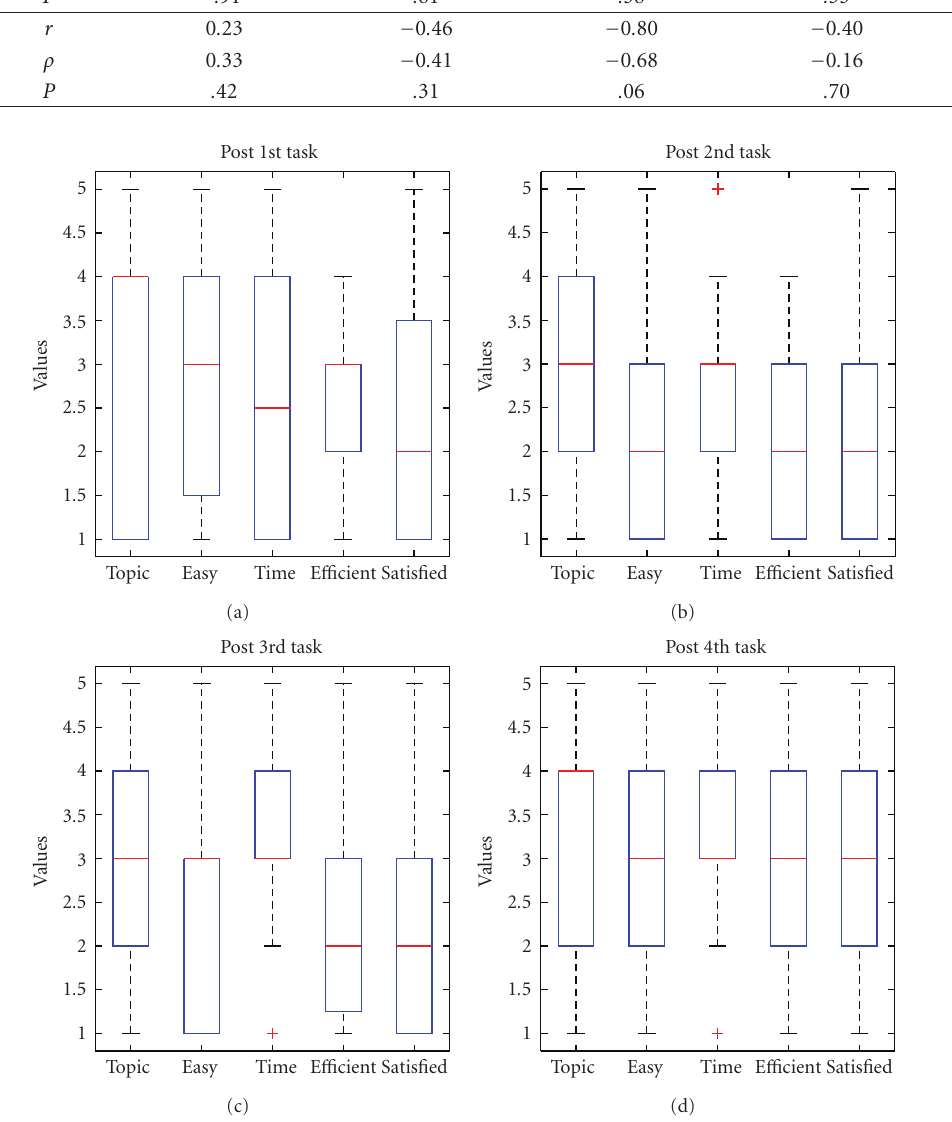
Figure 8: Results of the post-task question after each task done by the user using the desktop